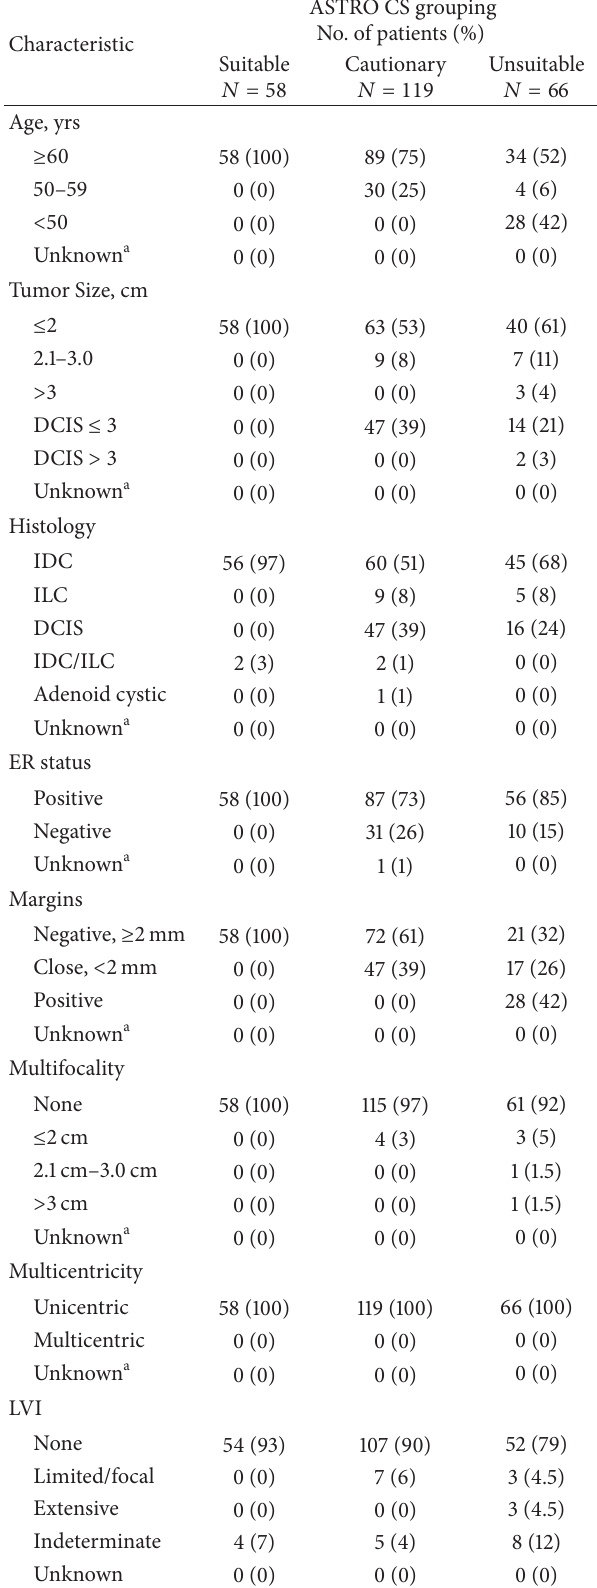
Table 2: Breakdown of patient cohort by individual clinical and pathologic characteristics stratified by ASTRO CS